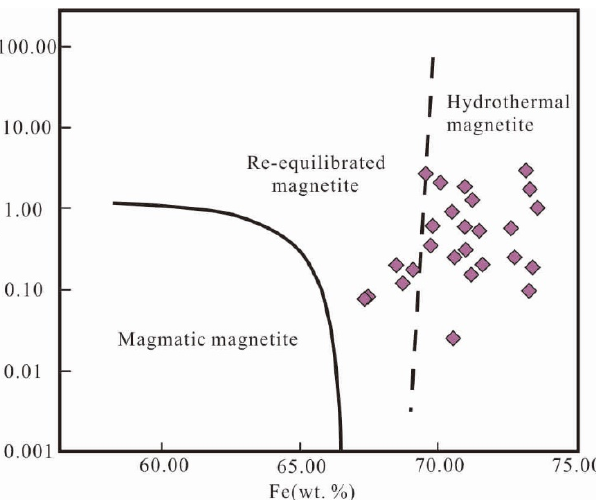
Figure 14. Fe vs. V/Ti genetic type discrimination diagram for magnetites from the skarn and ore of the Jinling deposit (modified from Wen [40]).